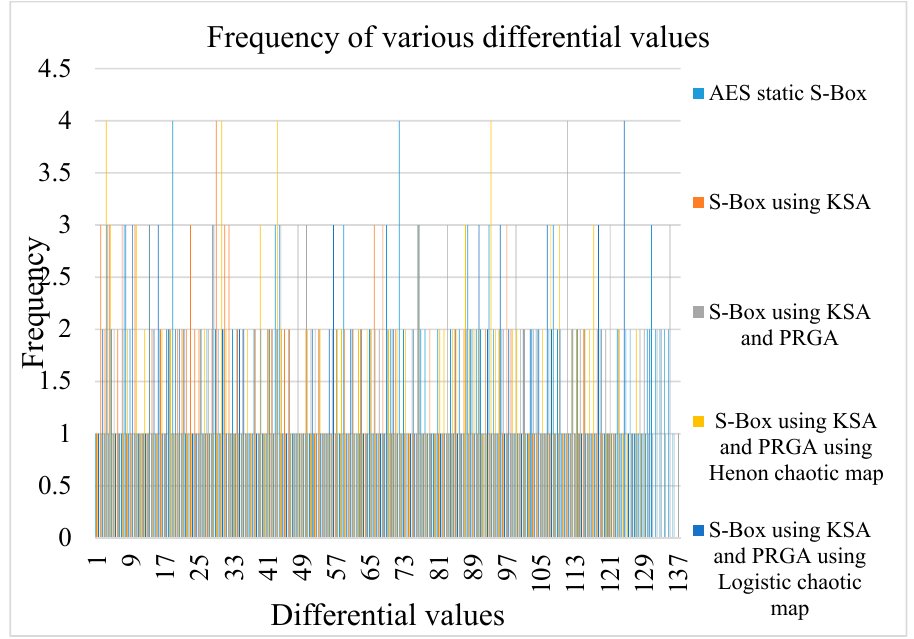
Figure 6. Analysis of the frequency of various values of ∆ Y for the 5 S-Boxes.